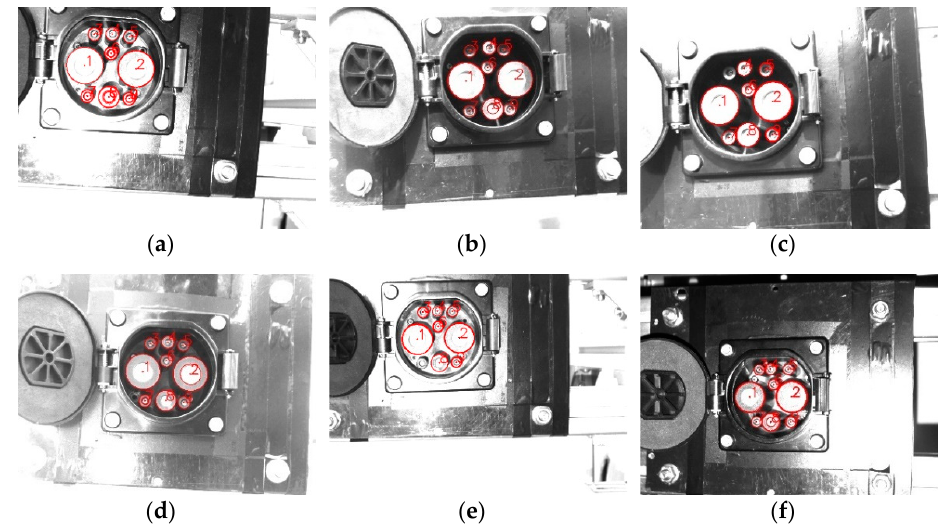
Figure 9. The recognition effect results in different scenarios in the search phase. ( a ) Indoor sunny